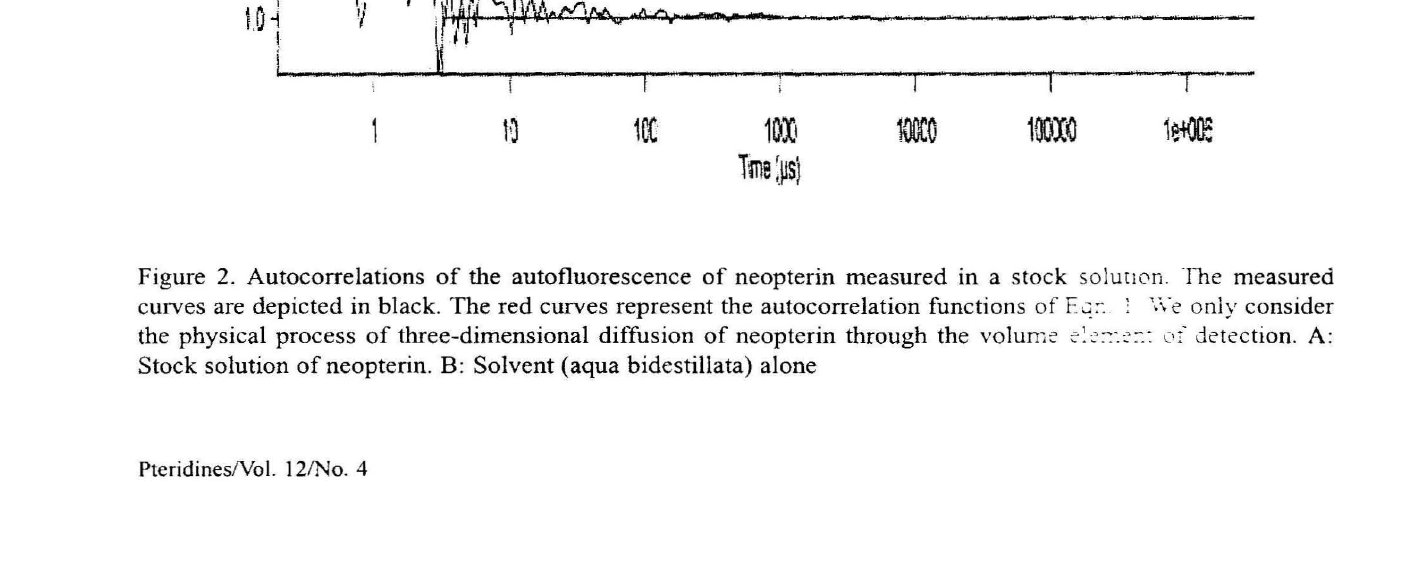
PteridinesIVol. 121No.